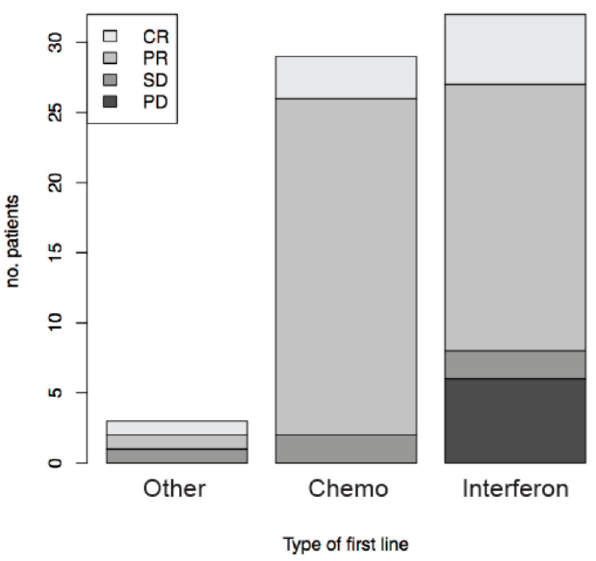
Figure 3. Best overall response after first line of systemic treatment in classic/endemic KS patients, according to type of therapy. Chemo: chemotherapy. CR: Complete Response. PR: Partial Response. SD: Stable Disease. PD: Progressive Disease.